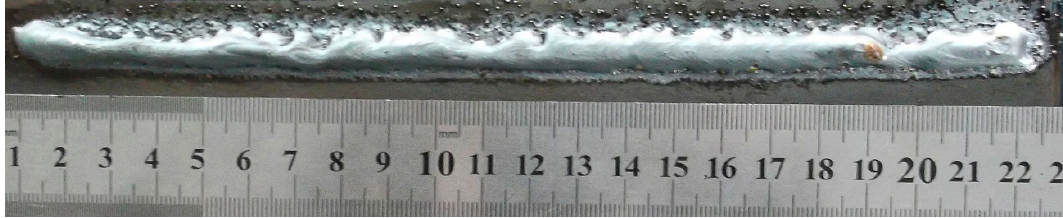
Figure 7. Welding seam of experiment 1.